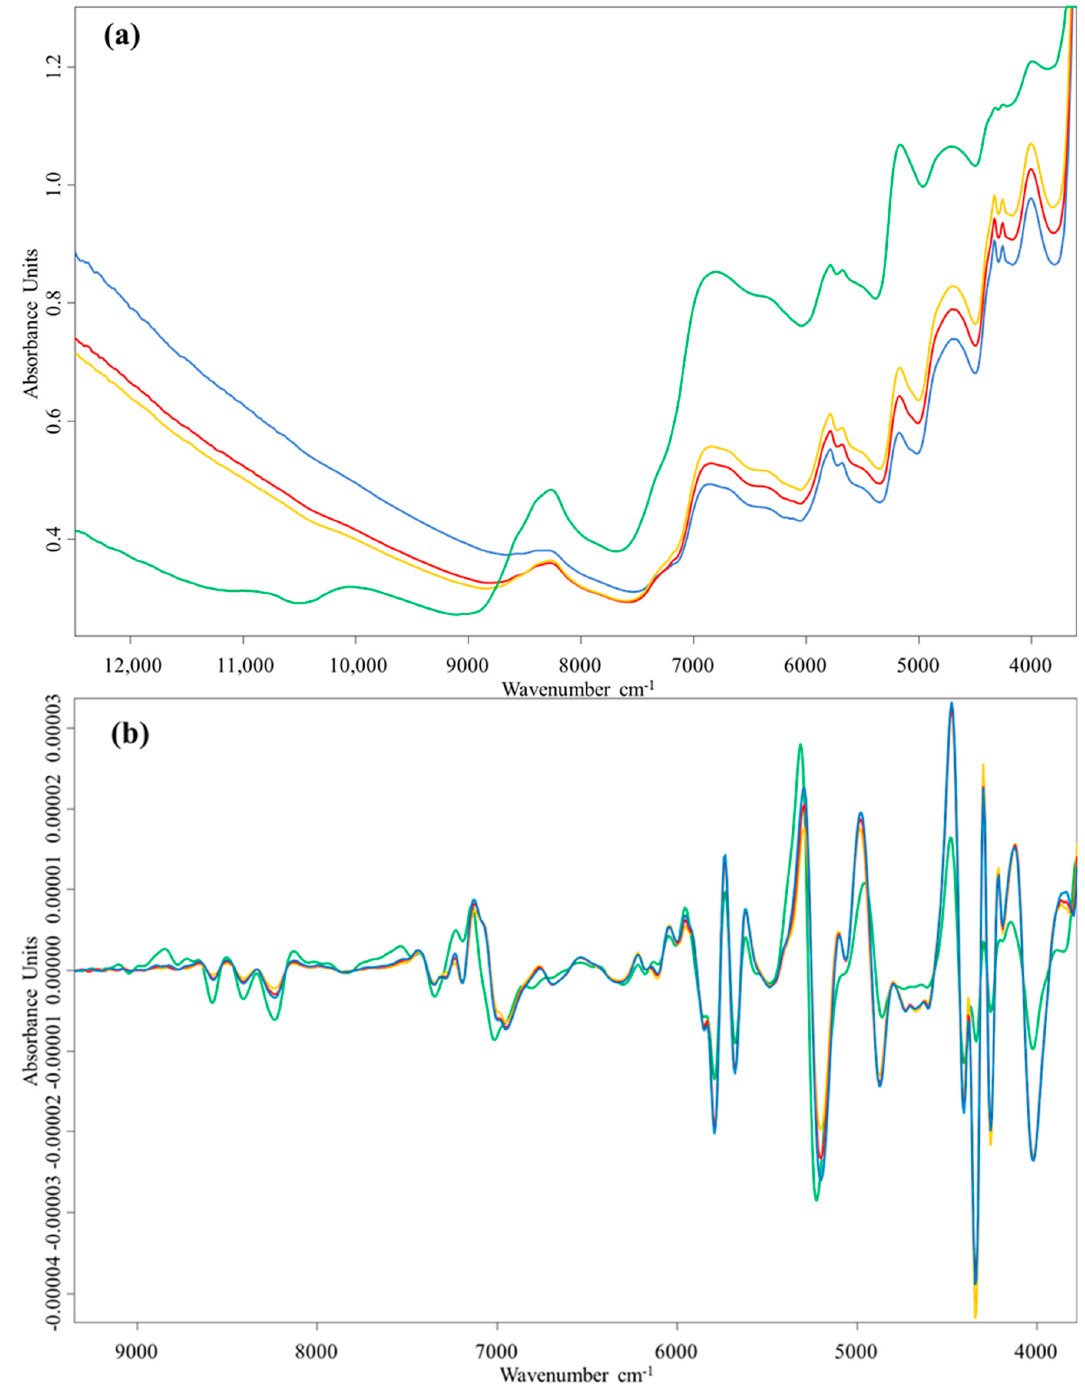
Figure 2. ( a ) The original average spectra of sample 1: raw ( • ), light roasted ( • ), medium roasted ( • ), Figure 2. (a) The original average spectra of sample 1: raw ( ● ), light roasted ( ● ), medium roasted ( ● ), dark roasted ( • ). ( b ) The second derivative spectra of sample 1: green ( • ), light roasted ( • ), medium dark roasted ( ● ). (b) The second derivative spectra of sample 1: green ( ● ), light roasted ( ● ), medium roasted ( • ), dark roasted ( • roasted ( ● ), dark roasted ( ● ).